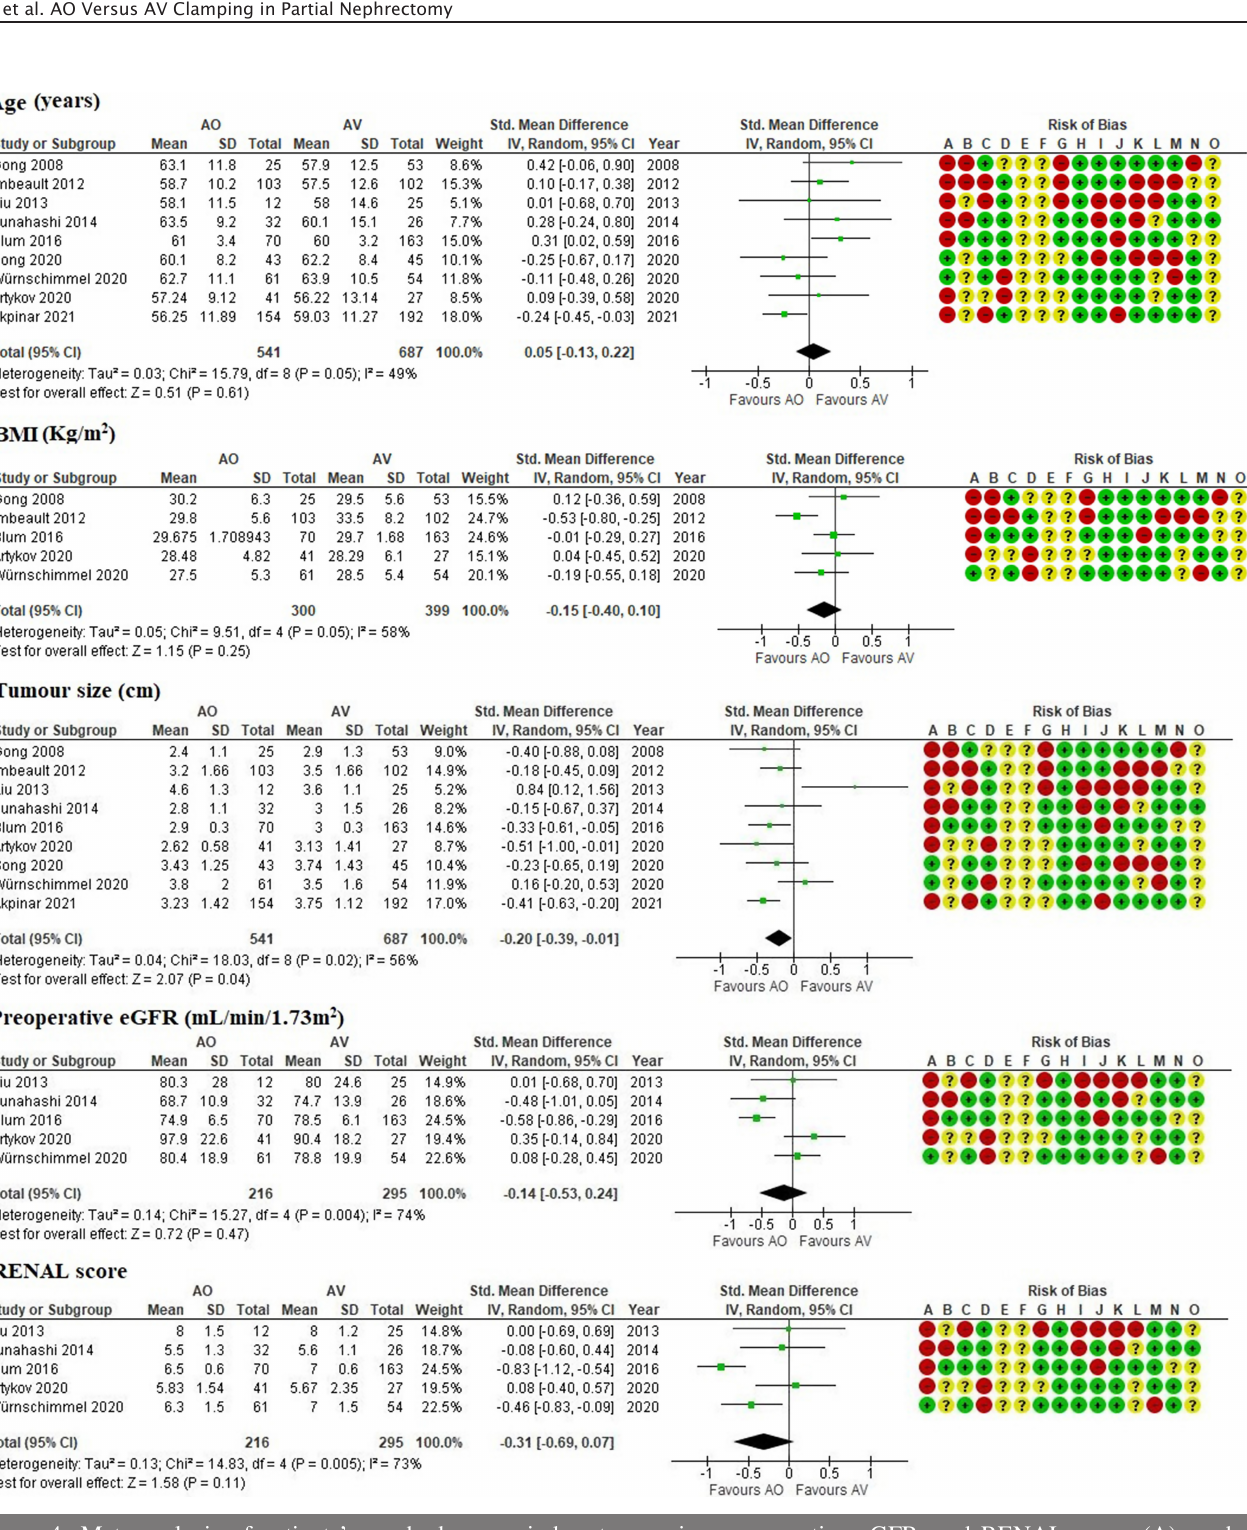
Figure 4. Meta-analysis of patients’ age, body mass index, tumor size, preoperative eGFR, and RENAL score. (A) random sequence generation/balanced groups; (B) allocation concealed/unrelated to confounders; (C) comparable groups at baseline; (D) equal care except for intervention; (E) Blinding participants; (F) blinding carers; (G) equal follow-up; (H) treatment completion; (I) available data of postoperative complications; (J) available data of transfusion rate; (K) available data of CKD; (L) appropriate length of follow-up; (M) precise definition of outcome; (N) valid reliable outcome assessment; (O) blinding of investigators. CKD, chronic kidney disease; eGFR, estimated glomerular filtration